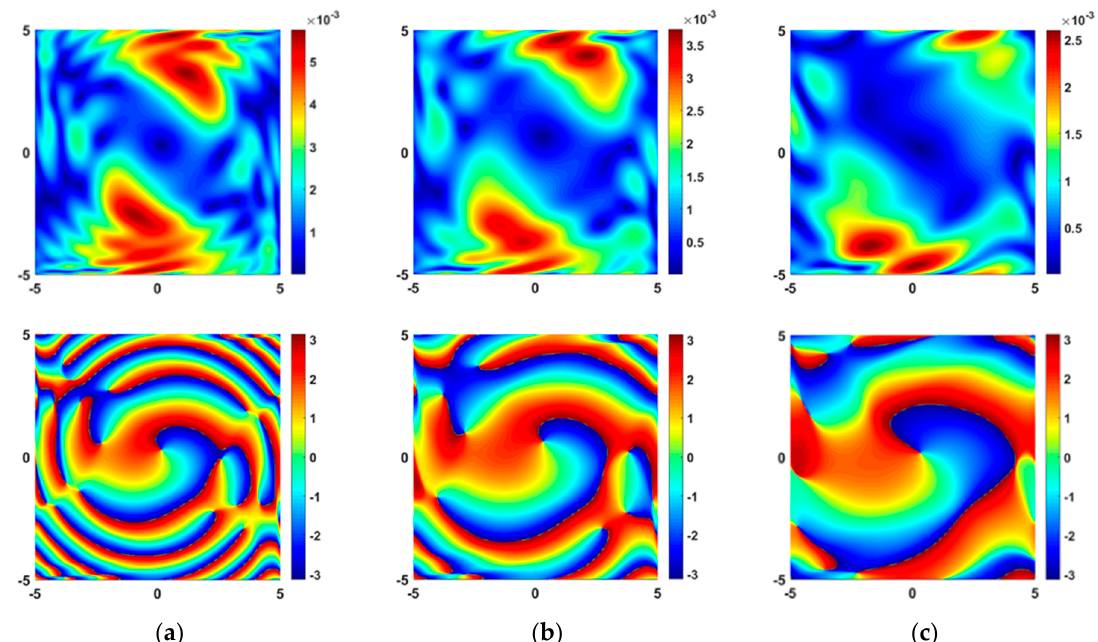
Figure 7. Intensity and phase distribution of electromagnetic vortex waves with the transmission distance ( a ) 1 km, ( b ) 5 km and ( c ) 10 km for multiplexing l = 1, 3, 5 under moderate-to-strong turbulence